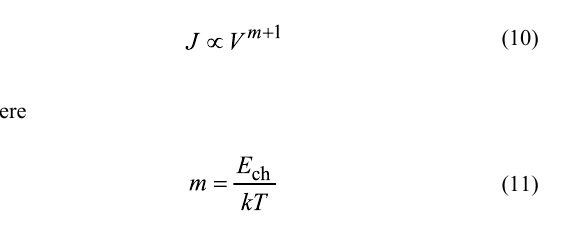
Figure 5: Comparison of the characteristic energy E ch,fit obtained by fitting Equation 10 to simulated current–voltage curves of electron-only devices assuming the characteristic energy E ch of the tail states that was used as input in the simulation. A high concentration of defects ( N T = 10 17 cm − 3 ) leads to a reduction of the current as shown in Figure 1a, which implies a much steeper slope of the curve in a certain voltage range. This will then be interpreted as a broader tail slope by Equation 10. If the concentration of defects is zero or low, Equation 10 will however underestimate the tail slope. The voltage range for the fits is 1 V < V < 8 V for the case with N T = 10 17 cm − 3 and 0.1 V < V < 8 V for all other